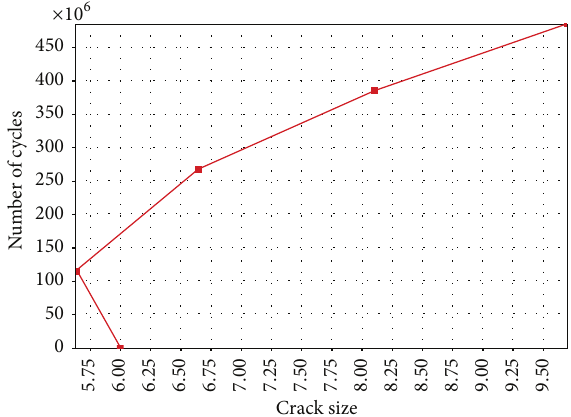
Figure 15: Relationship between loading cycle and crack